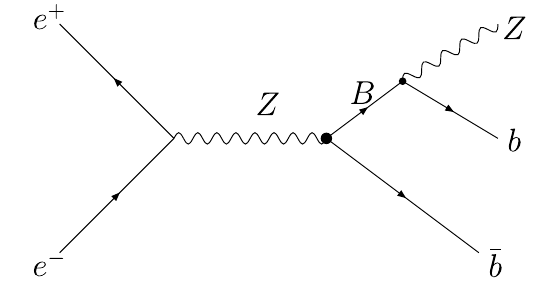
Fig. 2 Representative Feynman diagrams of the processes e + e − → B ( → Zb ) ¯